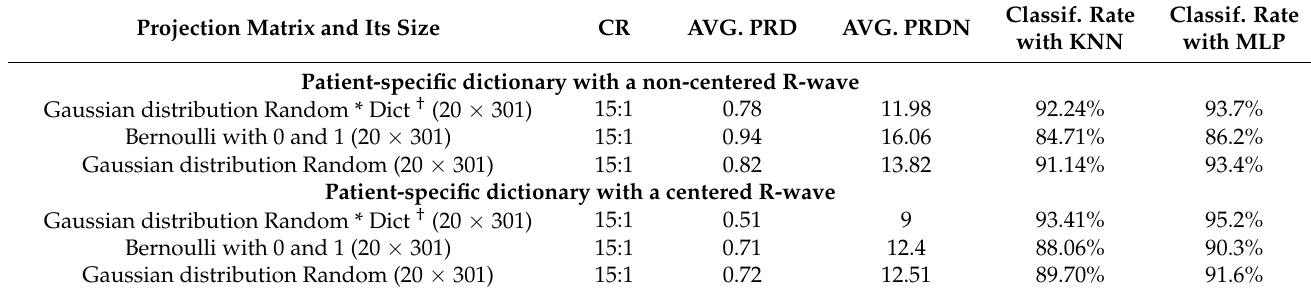
Table 3. Average results for 14 ECG records with the PSCCS method.